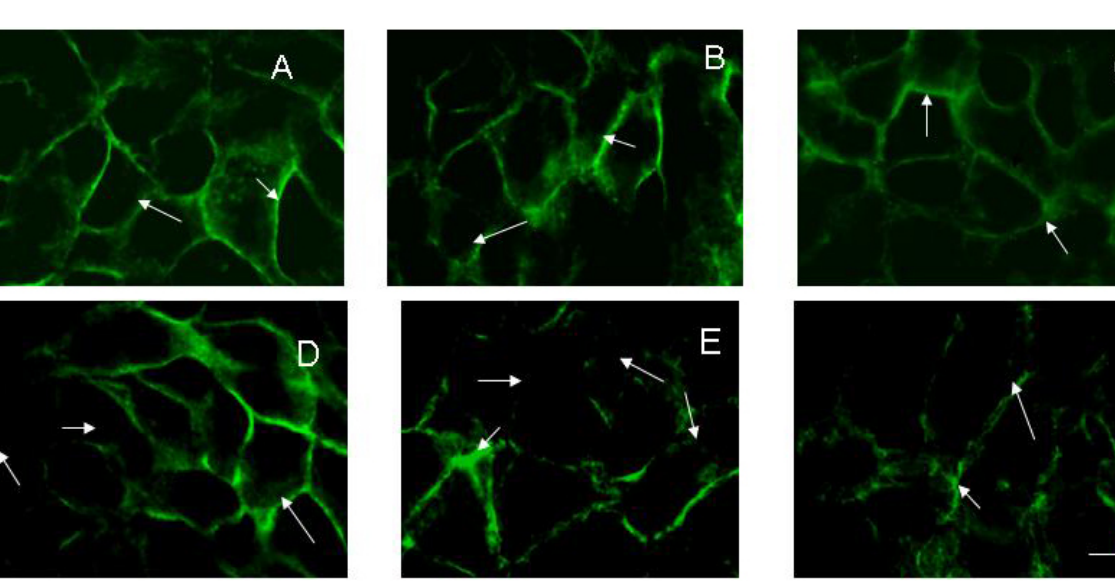
Figure 2. Fluorescent imaging of E-cadherin (Cy2-labelled; immunostaining) after treatment of HaCaT cells with electrical pulses and/or 20 μ g·mL − 1 rifampicin. ( A ) Untreated control HaCaT cells; ( B ) HaCaT cells, treated with 20 μ g·mL − 1 rifampicin alone; ( C ) HaCaT